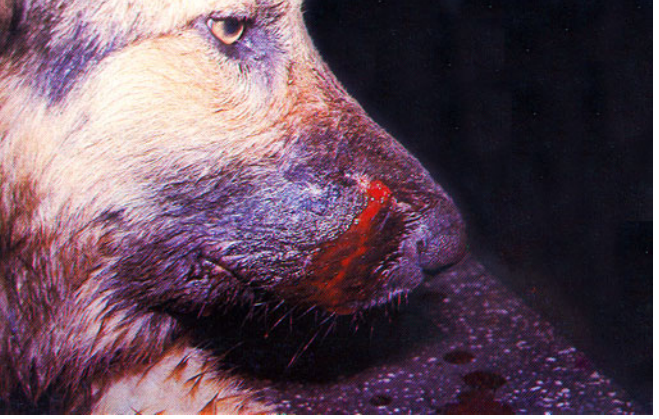
Figure 3. Dog muzzle bitten by Bothrops snake. Photograph kindly provided by Prof. Dr. Pedro Luis